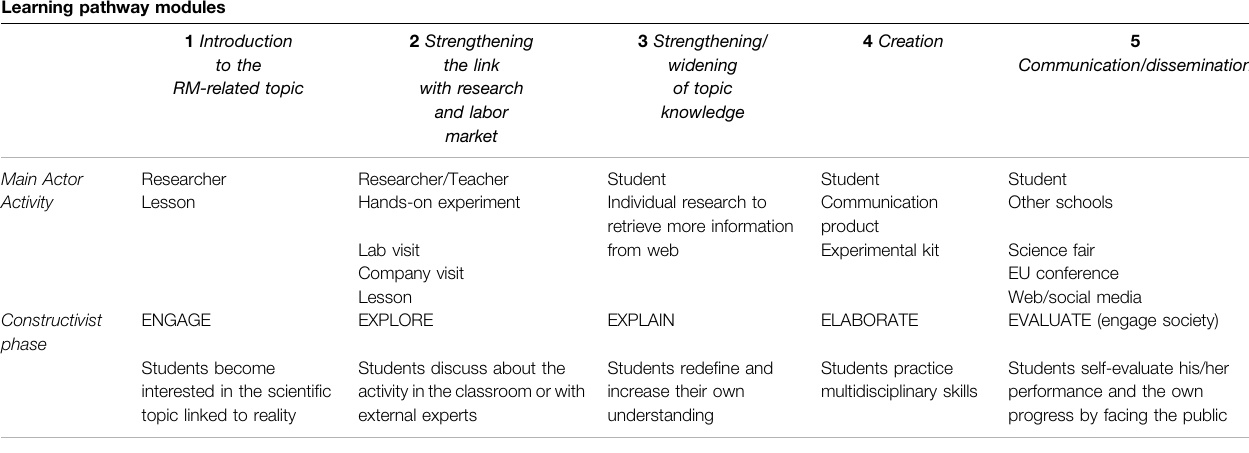
TABLE 1 | Modular structure of a learning pathway proposed to develop communication competencies and increase their awareness about sustainable development. The columns represent the modules and each module includes independent optional activities. Learning pathway modules